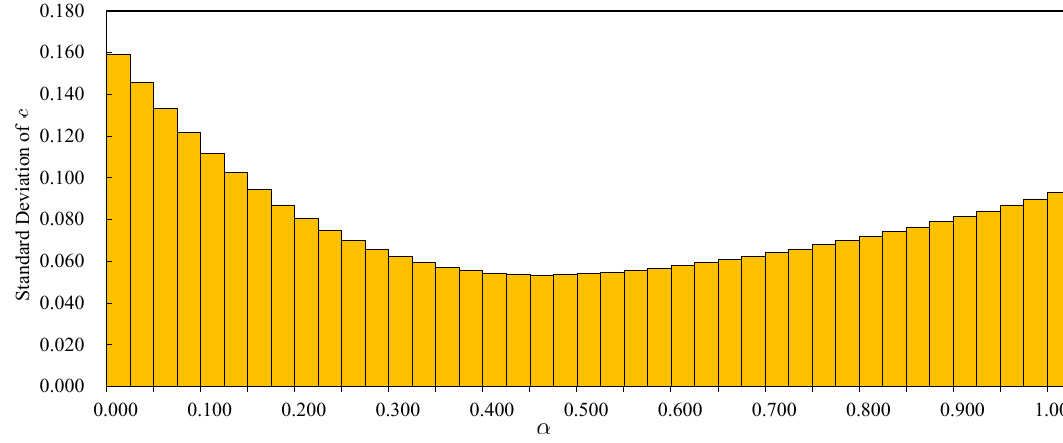
Figure 6 . The standard deviation of c = m tower / | Λ | α for each α in the case of anistropic SUSY vacua. The range of α shown in the figure is set as [0 . 000 , 1 . 000] and the increments are 0.025. In this figure, α = 0 . 450 gives the minimum value 5 . 36 × 10 − 2